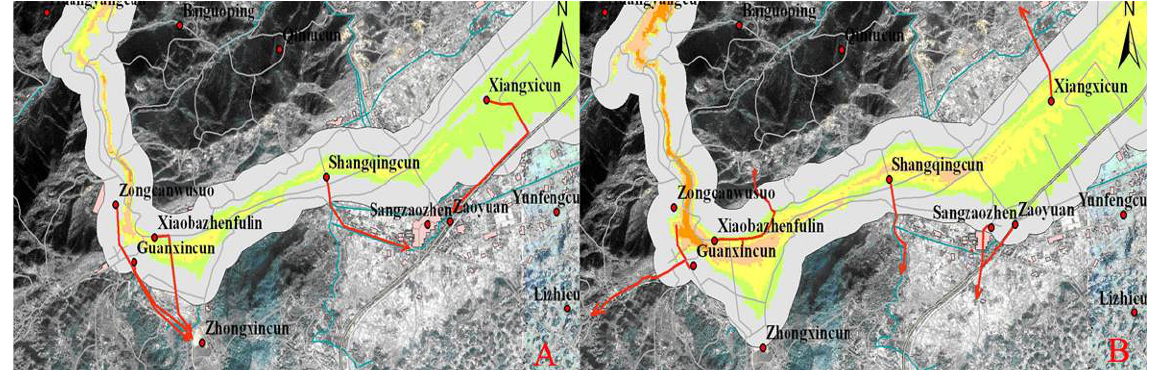
Table 5. Advantages of each step. Image acquisition Takes one or two hours, the UAV images Barrier lake information extraction Faster and more accurate Moderate efficiency and accuracy Overland flow simulation Inundation potential analysis